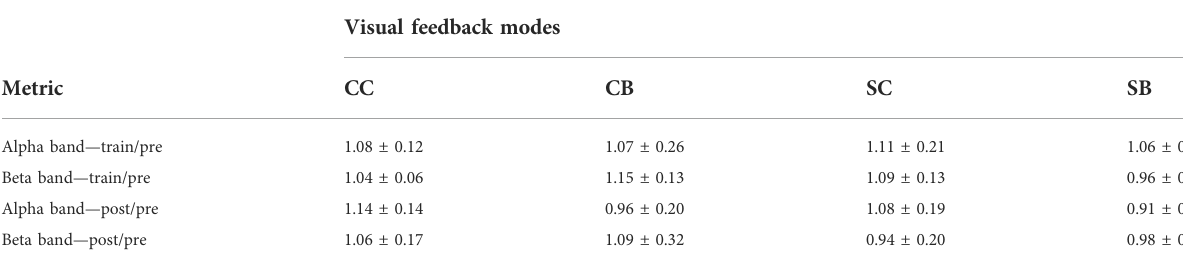
Table 3A: Mean EEG results for across visual feedback modes